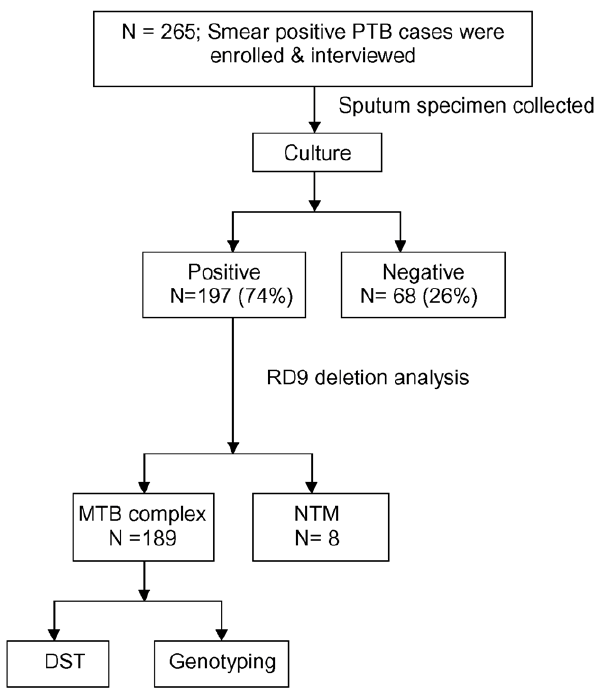
Figure 1. Flow diagram of tuberculosis patient at enrolment.